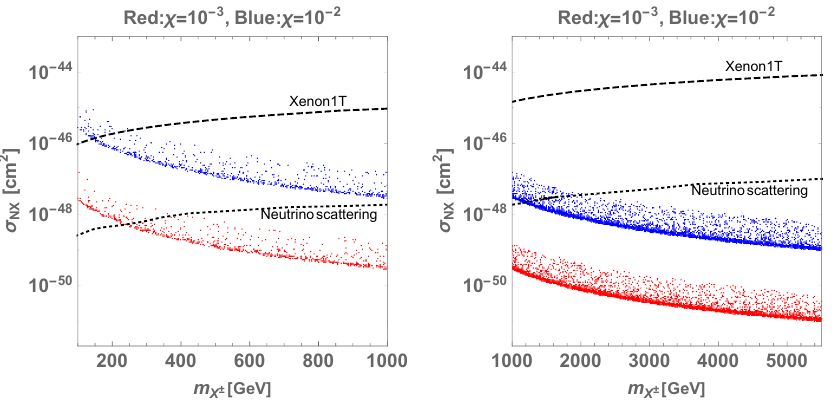
Figure 3 . Spin independent DM-nucleon scattering cross section for allowed parameter sets where dashed curve corresponds to XENON1T constraint and dotted curve corresponds to neutrino scat- tering